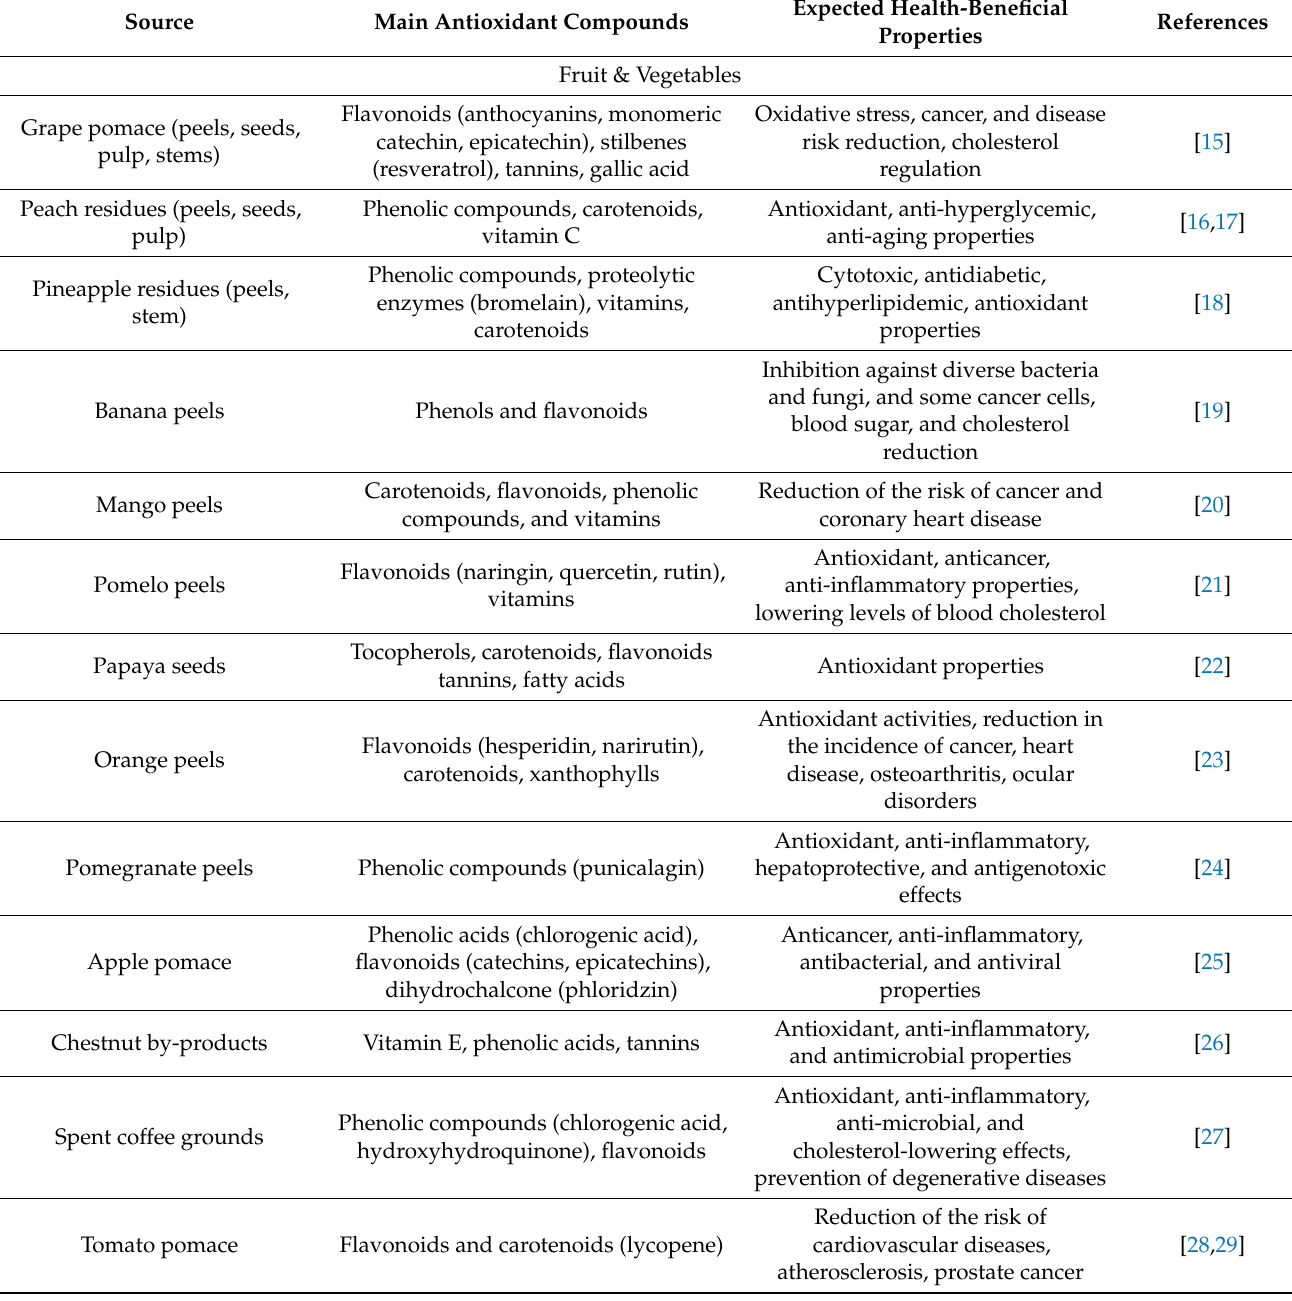
Table 2. Classification of the main agri-food by-products, the antioxidant compounds they are rich in, and the related expected beneficial